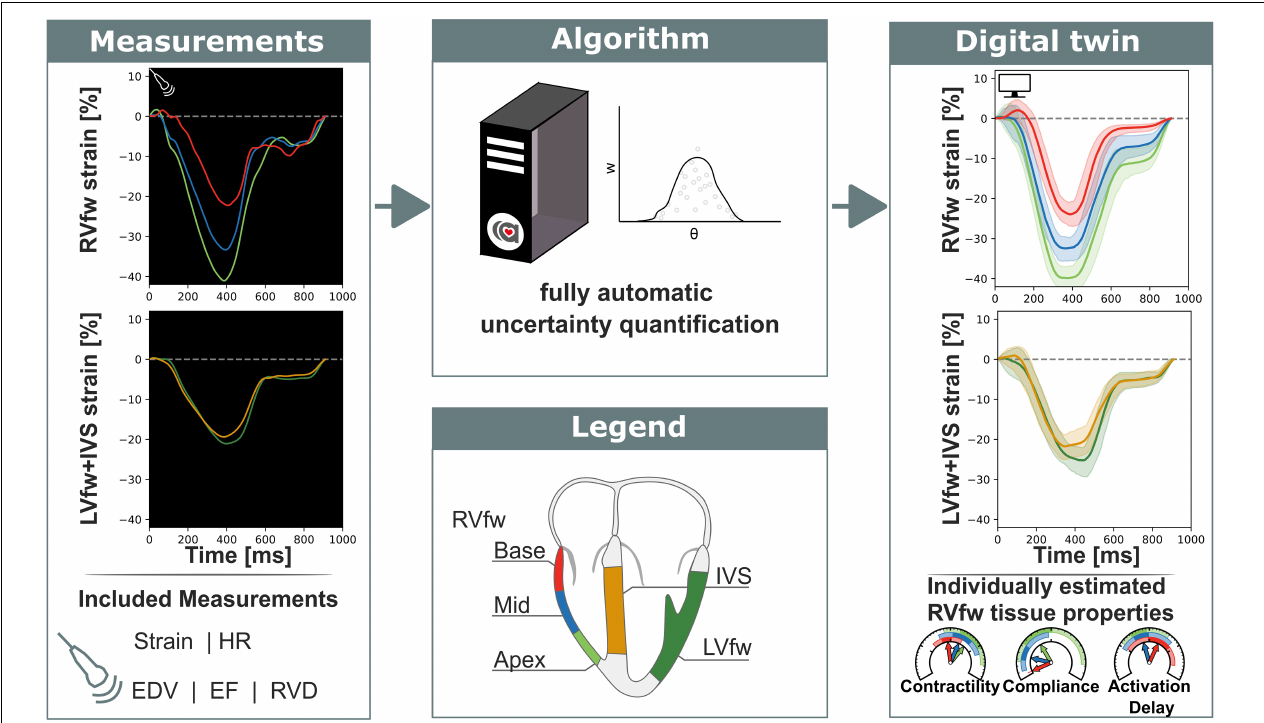
FIGURE 1 | Non-invasive measurements were used as input for a fully automatic automated uncertainty quantification algorithm. This algorithm produced a digital twin based on estimated parameters with accompanying uncertainty. This digital twin can be used to get more insight in the estimated tissue properties. RVfw, right ventricle free wall; LVfw, left ventricle free wall; IVS, inter ventricular septum; HR, heart rate; EDV, end-diastolic volume; EF, ejection fraction; RVD, right ventricular